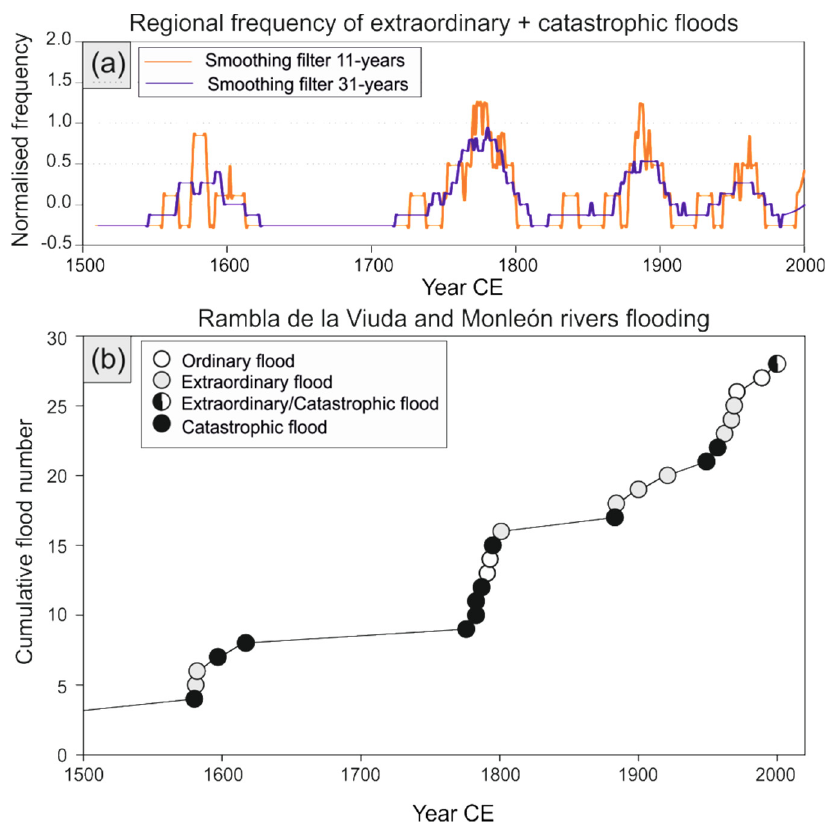
Figure 2. ( a ) Normalised annual flood series (this study) smoothed with a Gaussian filter (11 and 30 year, respectively) of extraordinary + catastrophic floods for the Castelló Province. The anomalies for AD 1500–1950 were estimated from documentary records, and after 1950 from instrumental data. Flood magnitude classification after Barriendos et al. [37]. ( b ) Accumulated number of documentary floods for Rambla de la Viuda and Montlleó rivers.